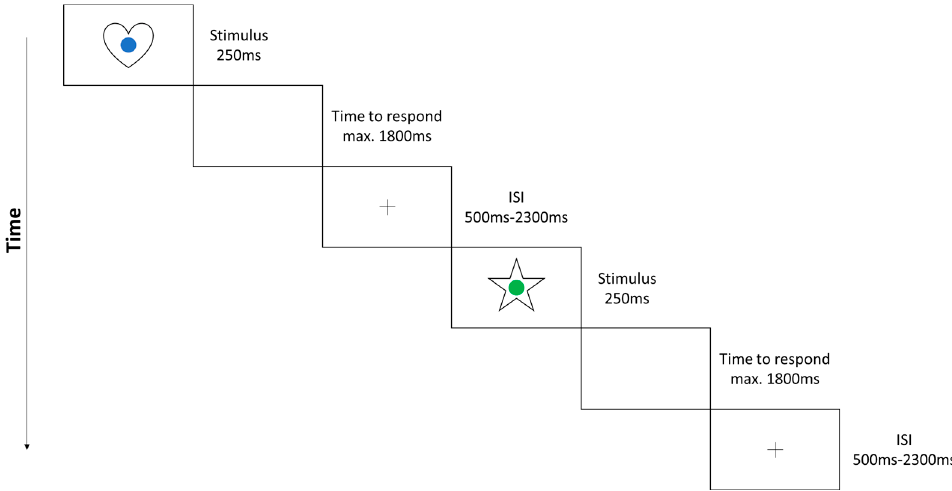
Figure 1. Overview of the SwAD-task procedure (child version) (see also Liebherr et al.,